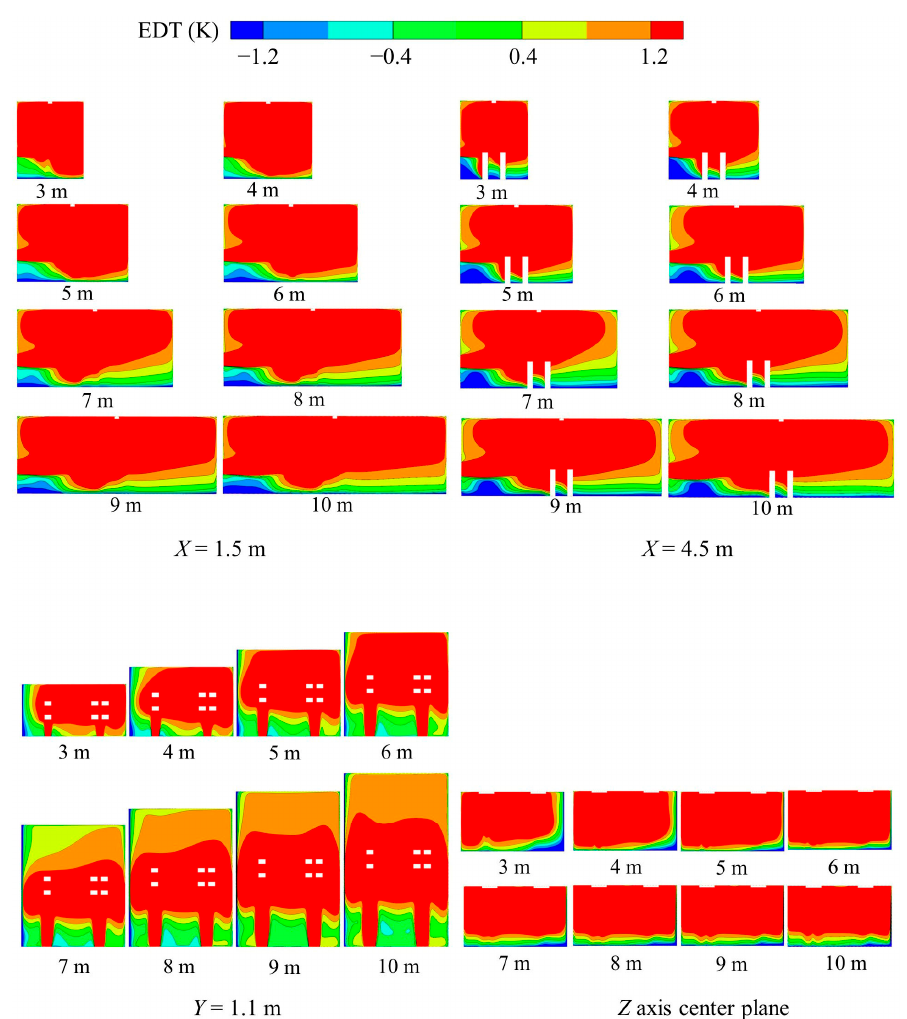
Figure 10. EDT distribution in different room size.